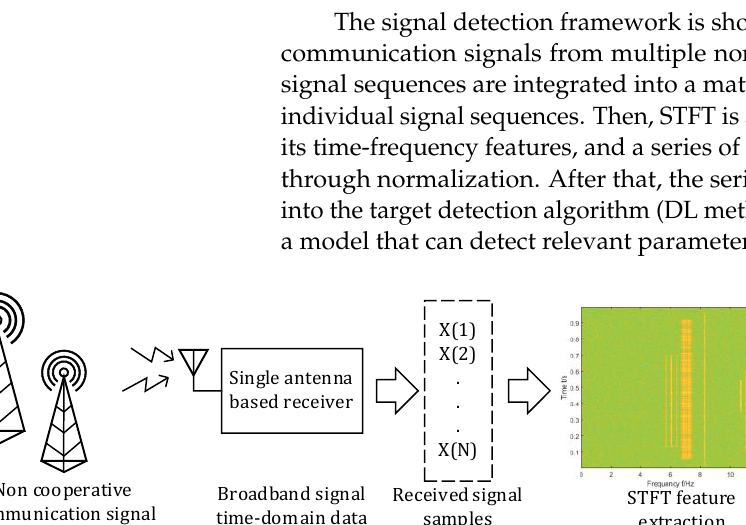
Figure 1. Deep learning method workflow block diagram.